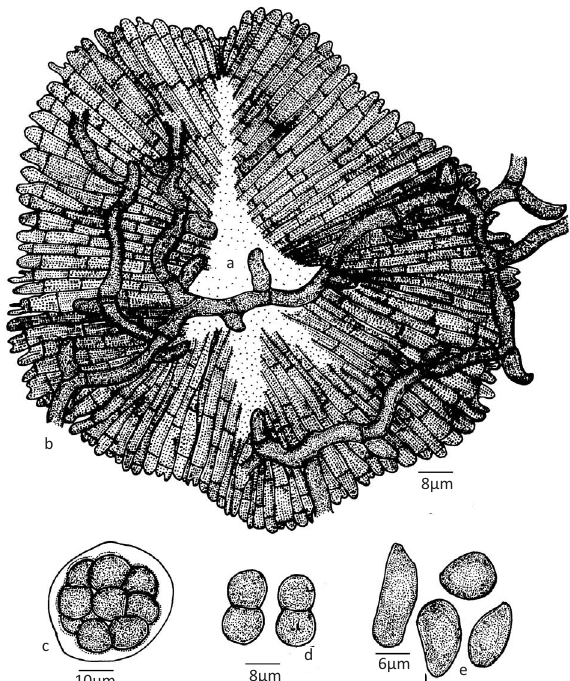
Figure 1. Asterina congesta (microscopic details) a - Mycelium; b - Ascomata; c - Ascus, d - Ascospores, e -